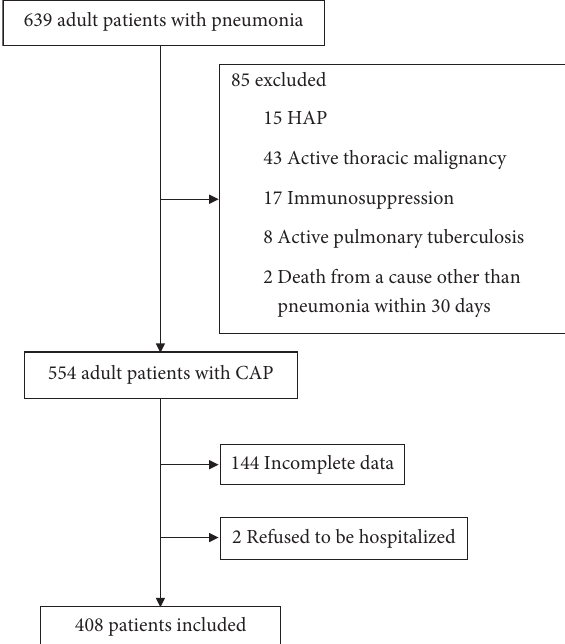
Figure 1: Study flow diagram showing patient selection. Abbre- viations: CAP, community-acquired pneumonia; HAP, hospital- acquired